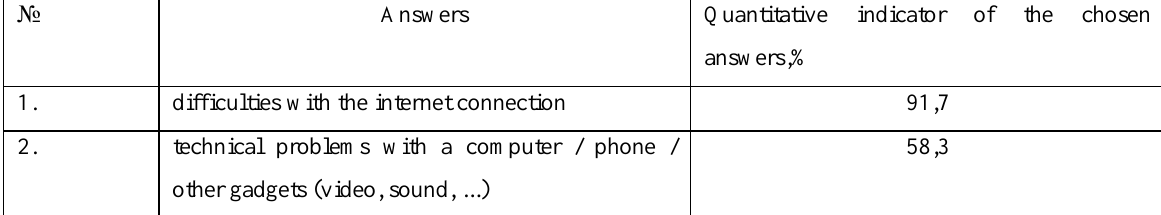
Table 2. Answers to the question “What problems do you face when you work with the